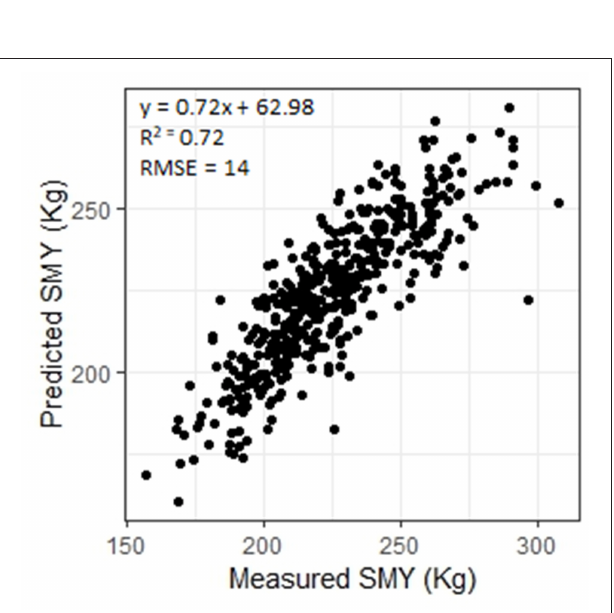
FIGURE 4 | Measured saleable meat yield (SMY) plotted against SMY predicted using an artificial neural network.